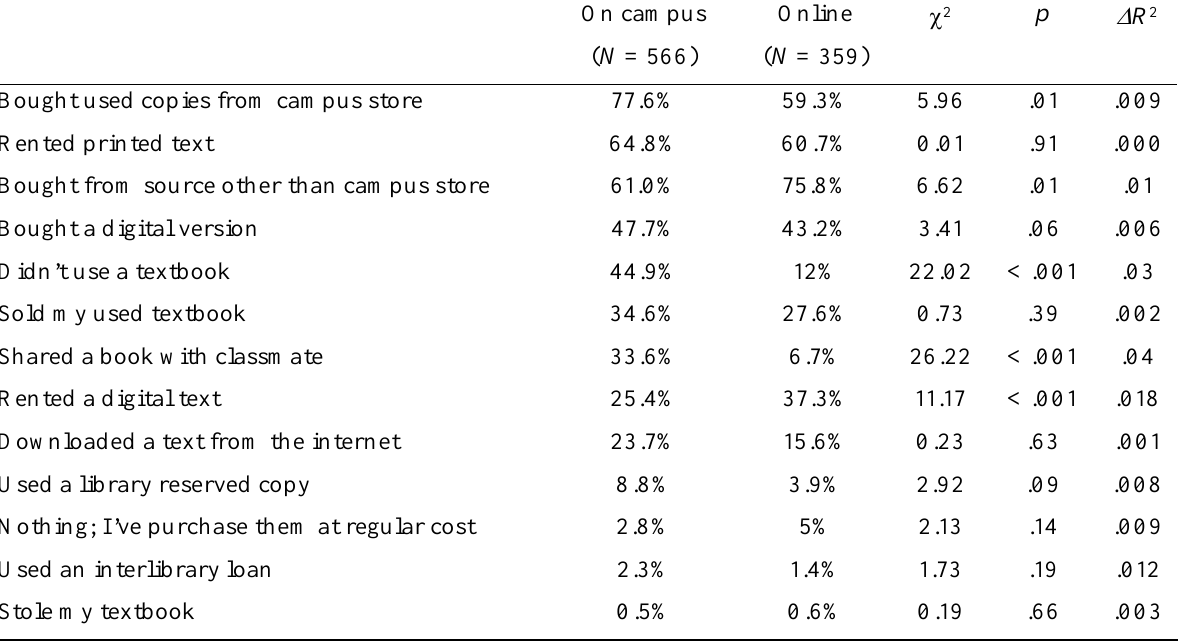
Comparisons of the Strategies Used to Offset Textbook Costs Endorsed by Online Versus On- Campus